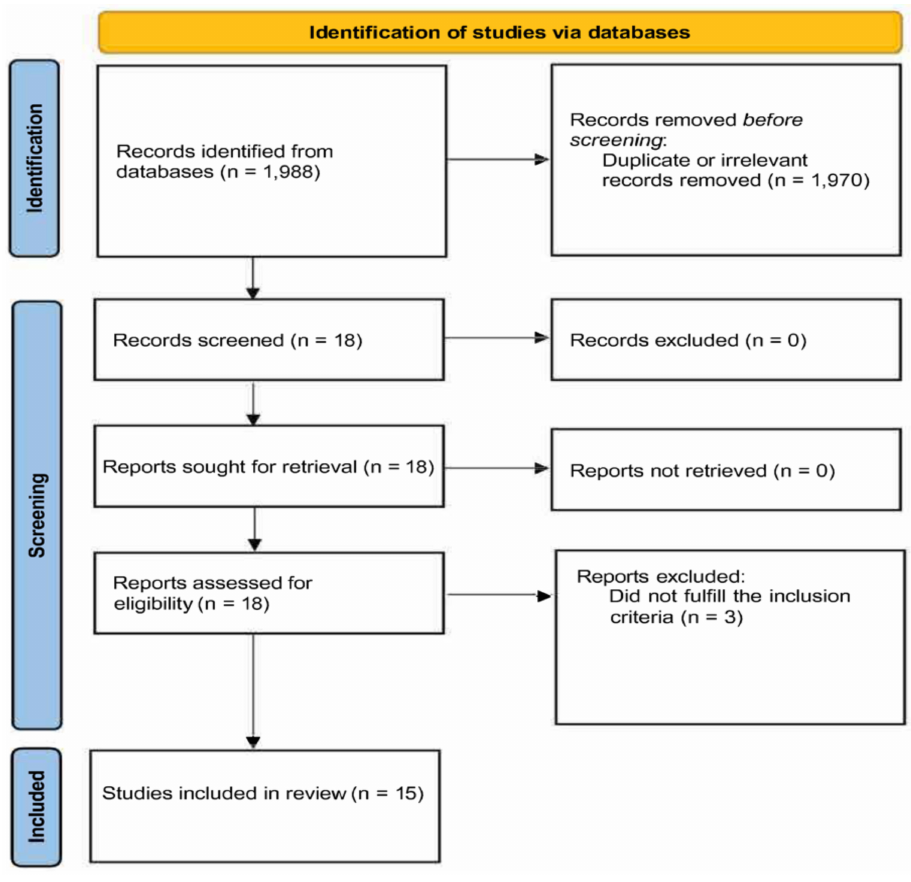
Figure 1. PRISMA 2020 flow